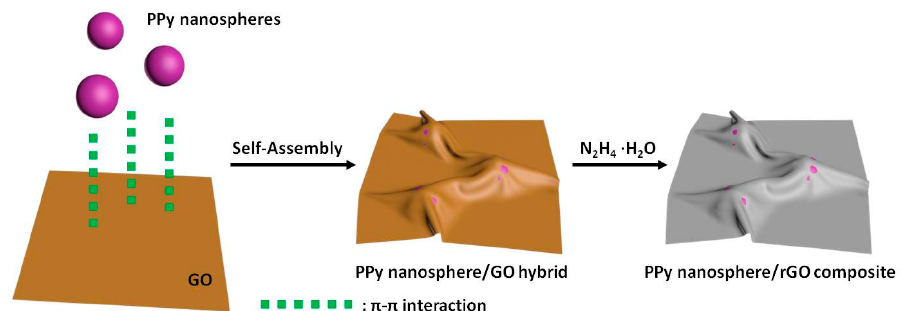
Figure 1. Schematic illustration of preparing polypyrrole (PPy) nanosphere/reduced graphene oxide (rGO) composite.